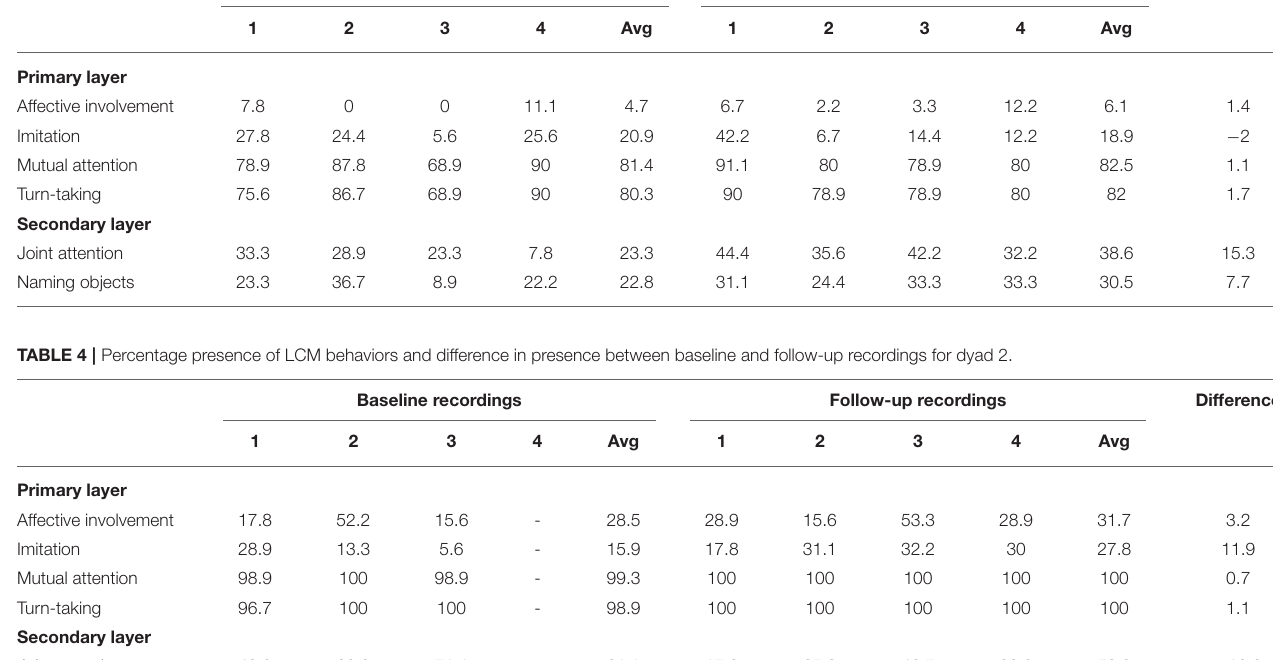
TABLE 3 | Percentage presence of LCM behaviors and difference in presence between baseline and follow-up recordings for dyad 1. Baseline recordings Follow-up recordings